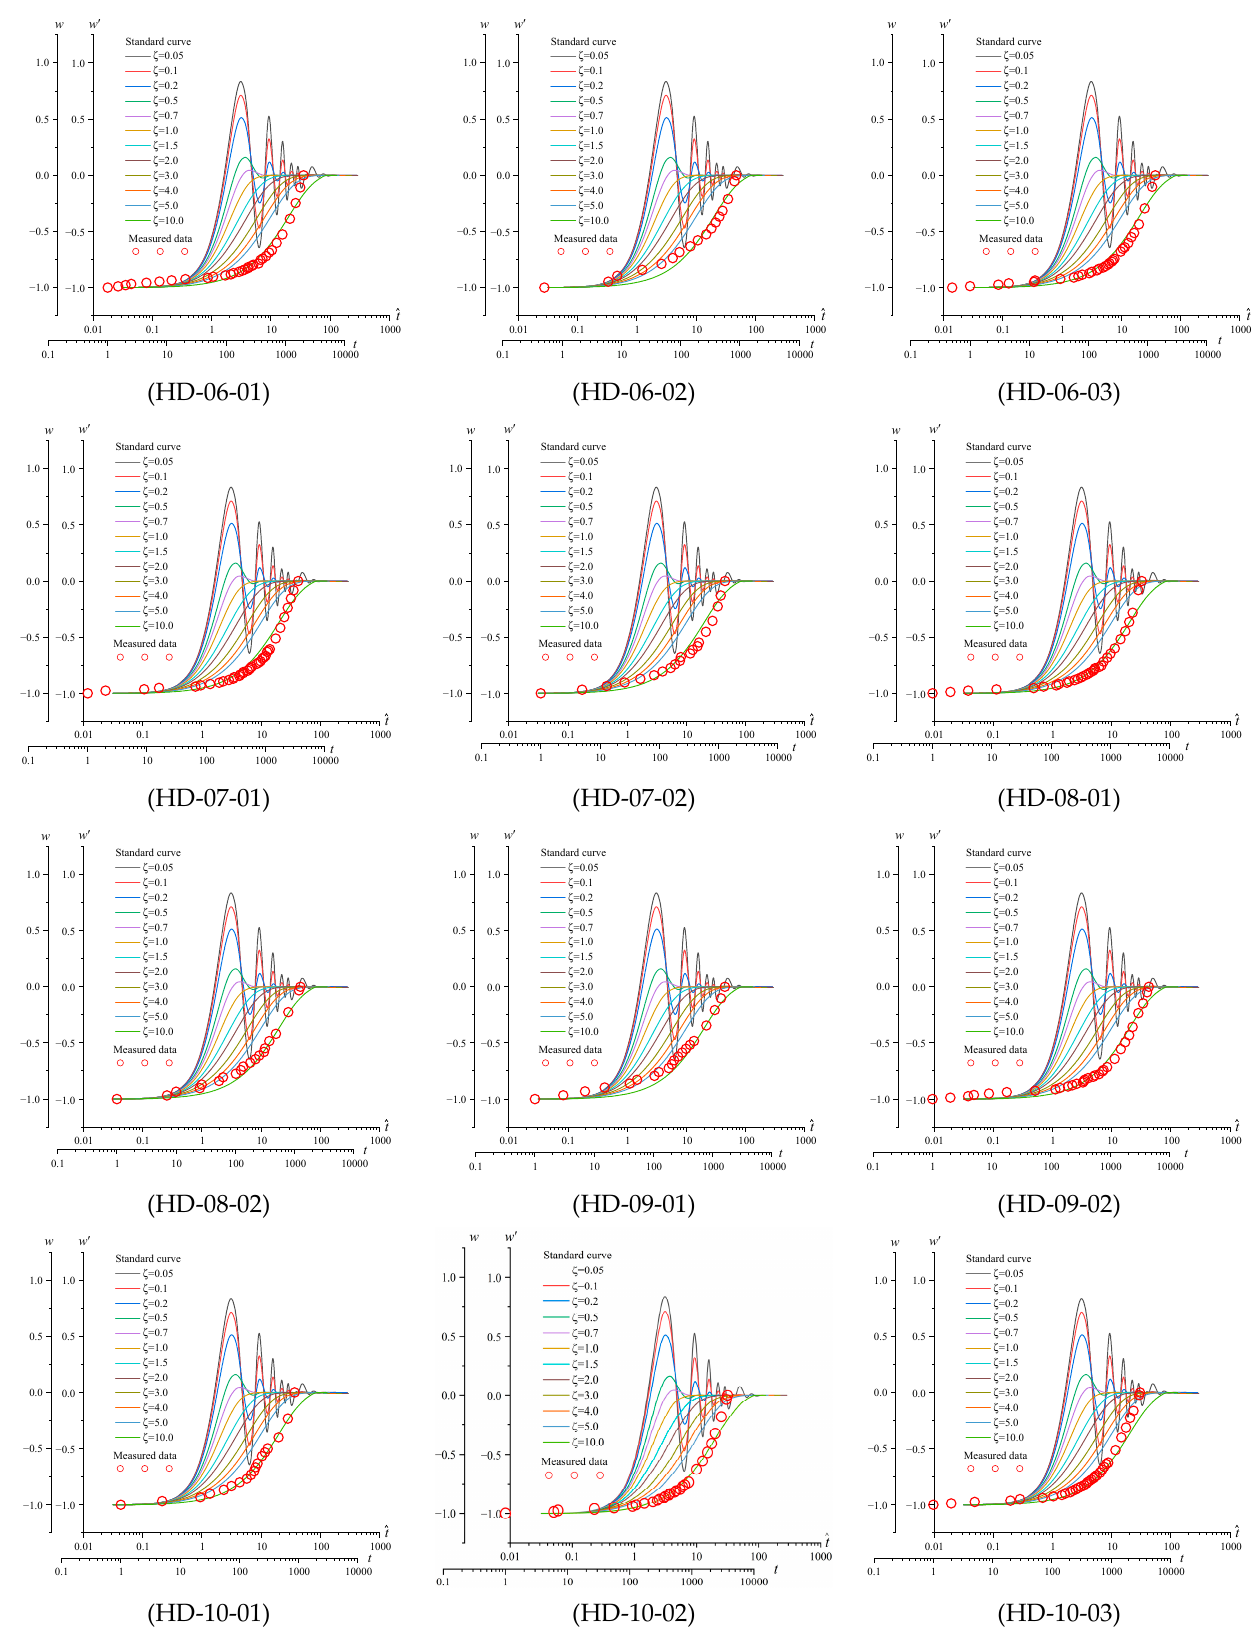
Figure 7. Fitting curve of slug test.